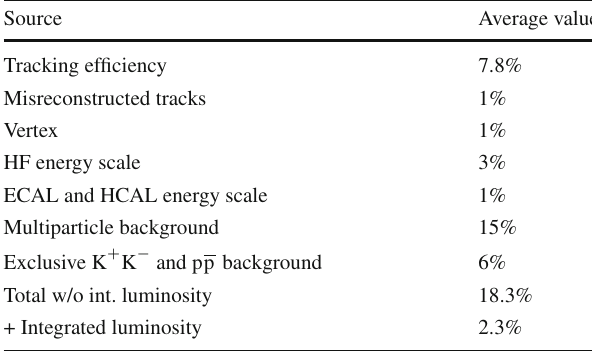
Table 4 The sources and average values of systematic uncertainties, used as the systematic uncertainty of the total cross section